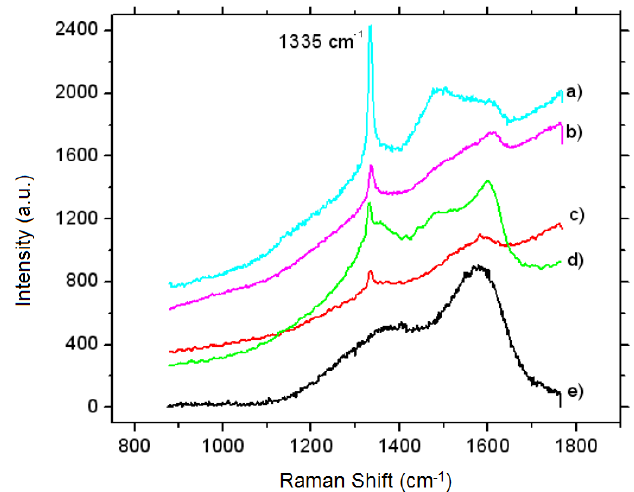
Figure 7. The Raman spectra (excitation with laser at 514.5 nm) on: ( a ) AISI M2 Fe 2 B (4 h) + FeB (0.5 h); ( b ) AISI M2 Fe 2 B (4 h) + FeB (0.25 h); ( c ) AISI 1020 Fe 2 B (4 h) + FeB (0.25 h); ( d ) AISI M2 Fe 2 B (4 h); and ( e ) AISI 1020 Fe 2 B (4 h).